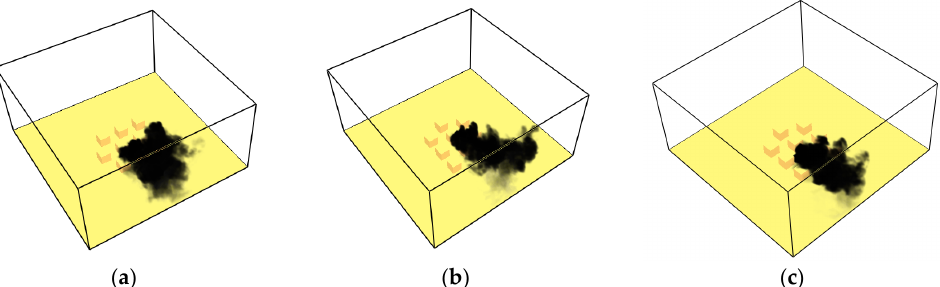
Figure 6. Snapshots of the dispersion of smoke after 200 s of the incidence for ( a ) Case 1; ( b ) Case 2; ( c ) Case 3.